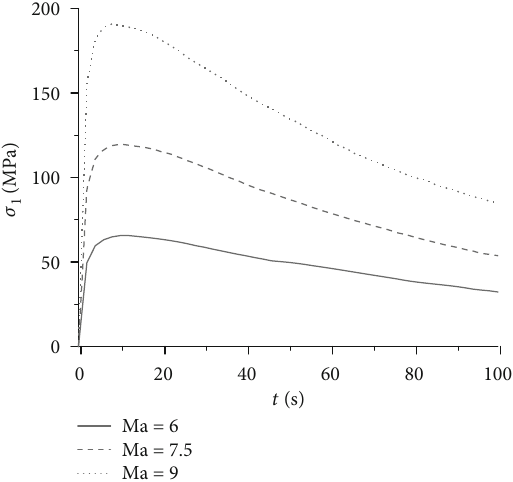
Figure 19: Maximum principal stress distribution along the axis. Figure 21: E